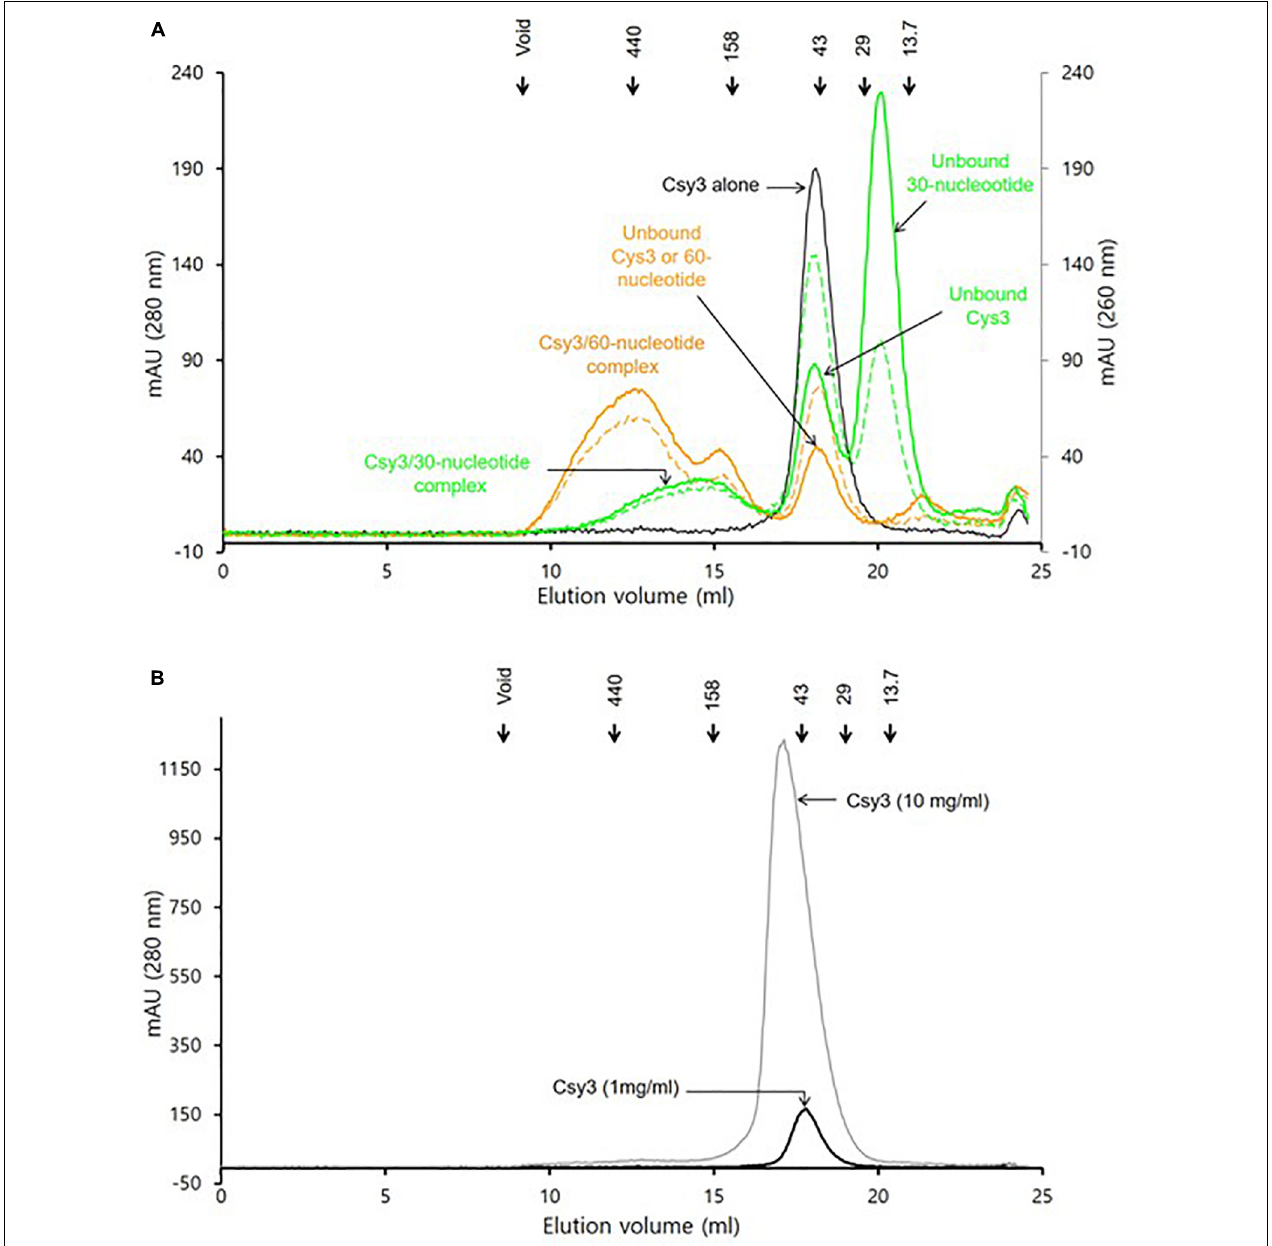
FIGURE 3 | Analysis of the oligomeric state of ZmCsy3 with and without crRNA. (A) The size distribution of ZmCsy3 with 60-nucleotide crRNAs (orange line, 260 nm: orange dash, 280 nm) or 30-nucleotide crRNAs (green line, 260 nm: green dash, 280 nm) and ZmCsy3 alone (black line, 280 nm) were checked using an analytic size exclusion column. (B) The concentration dependent oligomeric state of ZmCsy3 was checked at the concentration (black line, 1 mg/ml) used for the complex formation with crRNA and the 10-fold excess concentration (gray line, 10 mg/ml). The known standard molecular weights in kDa are marked in the elution